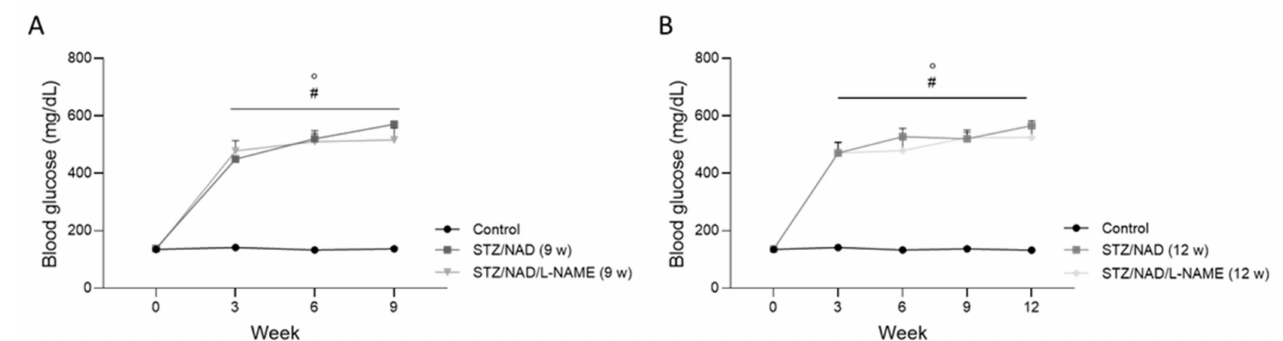
Figure 2. Blood glucose levels in diabetic STZ/NAD and STZ/NAD/L-NAME rats for a period of 9 ( A ) or 12 weeks ( B ) and non-diabetic control rats. Data are presented as mean ± SEM. * p < 0.05 vs. STZ/NAD, # p < 0.05 vs. non-diabetic control animals, and ◦ p < 0.05 vs. baseline